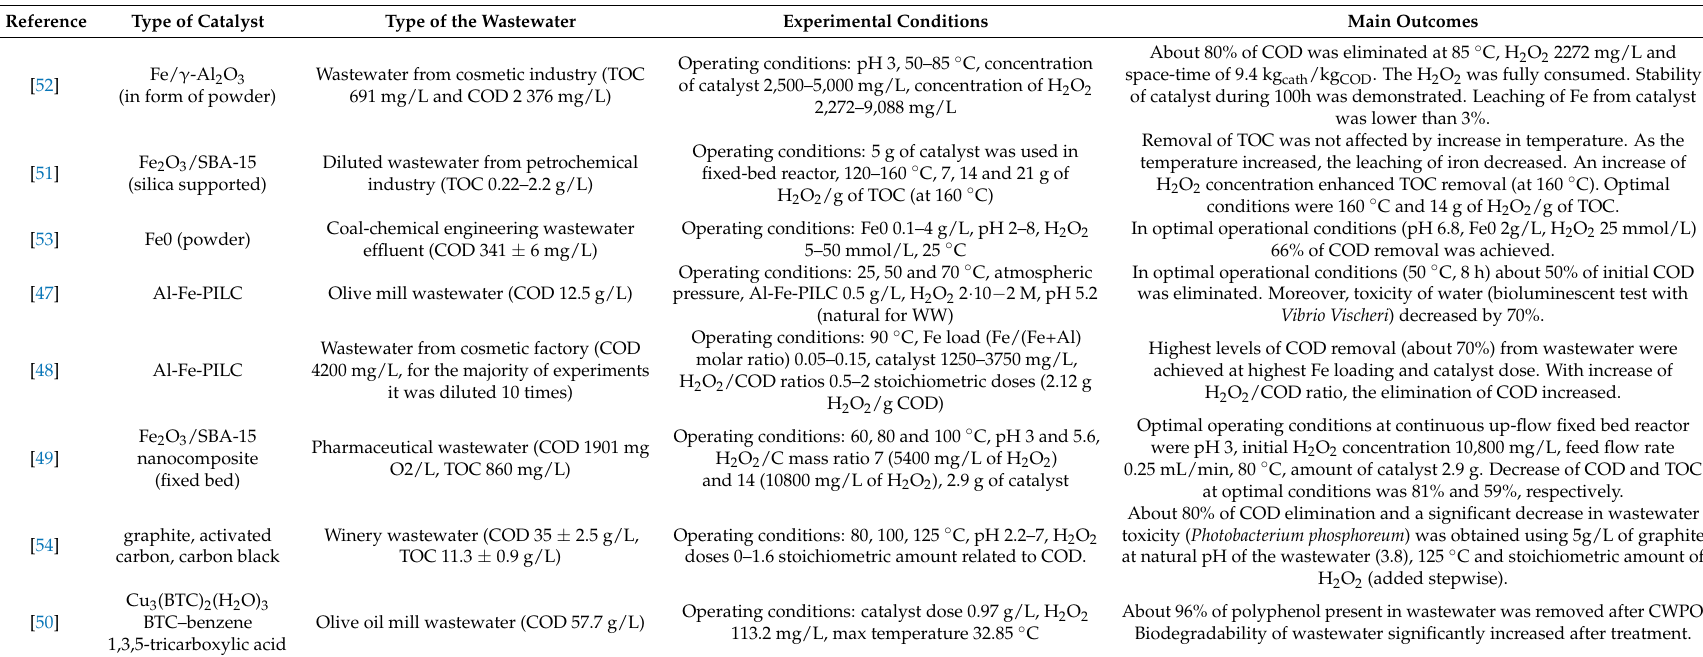
Table 1. CWPO for Increasing Biodegradability of Industrial